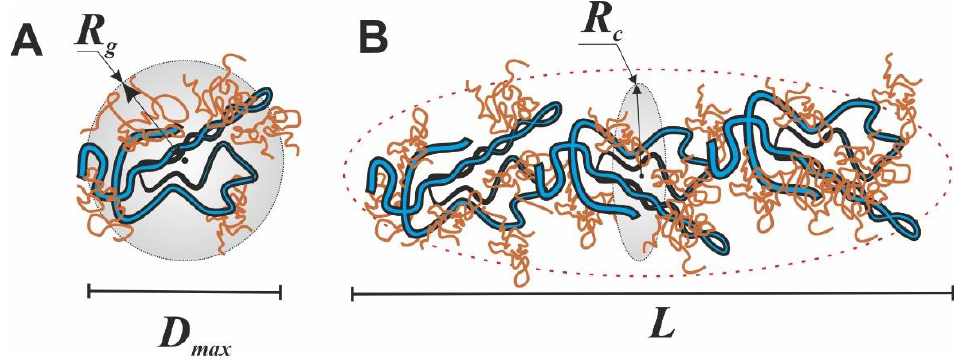
Figure 5. Structural schemes of spherical ( A ) and cylindrical ( B ) models indication of determined parameters.